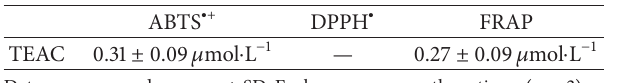
Table 1: TEAC values of XN as determined by ABTS ∙ + , DPPH ∙ , and FRAP.